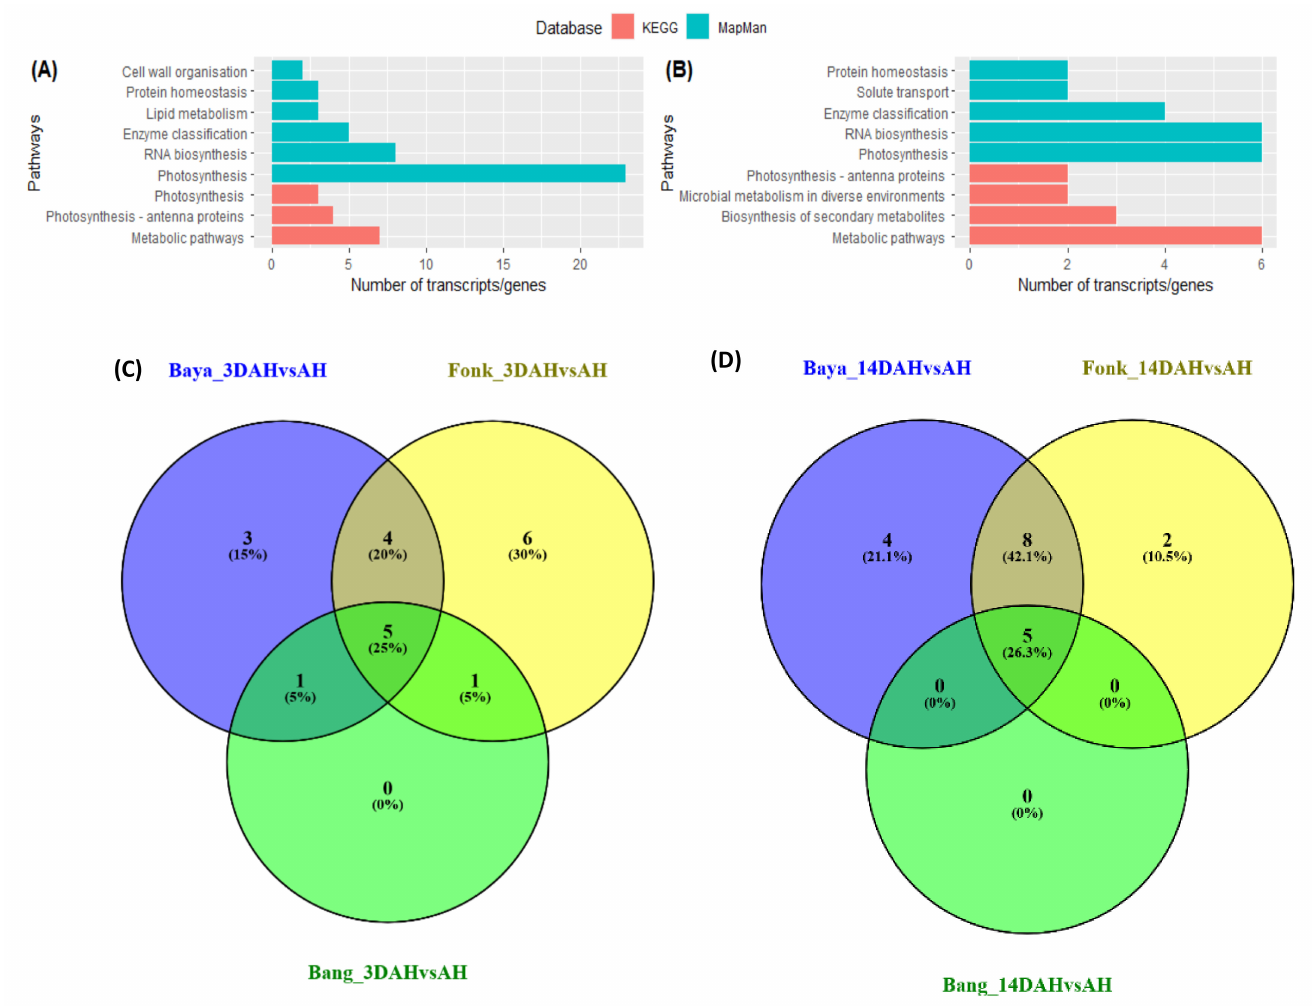
Figure 5. Functional classification of DEG after harvest. ( A , B ) the most enriched pathways of the combined analysis of three hardening accessions 3DAH and 14DAH, respectively. ( C , D ) Venn diagrams the most enriched pathways of each hardening accession 3DAH and 14DAH respectively. Green bars represent pathway annotation with MapMan data-base, and red bars represent pathway annotation with the Kyoto encyclopedia of genes and genomes (KEGG)